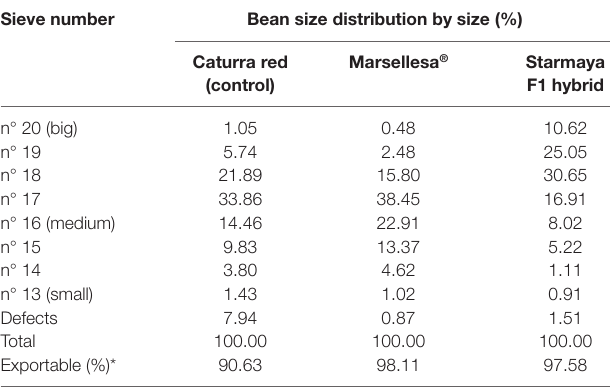
TABLE 7 | Size distribution (expressed in percentage) of green coffee beans of Catura red, Marsellesa ® , and Starmaya varieties of C. Arabica (2015–2016 harvest).